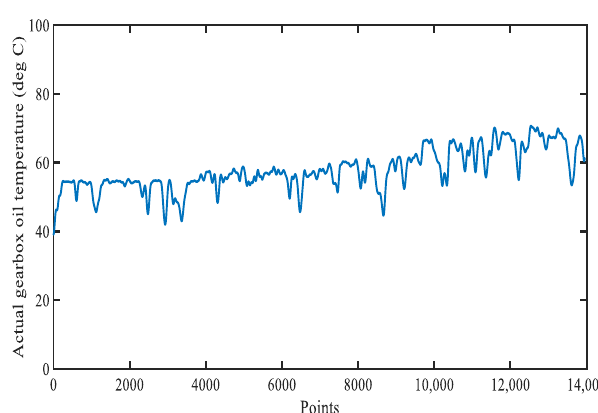
Figure 9. MD value for prediction model input.